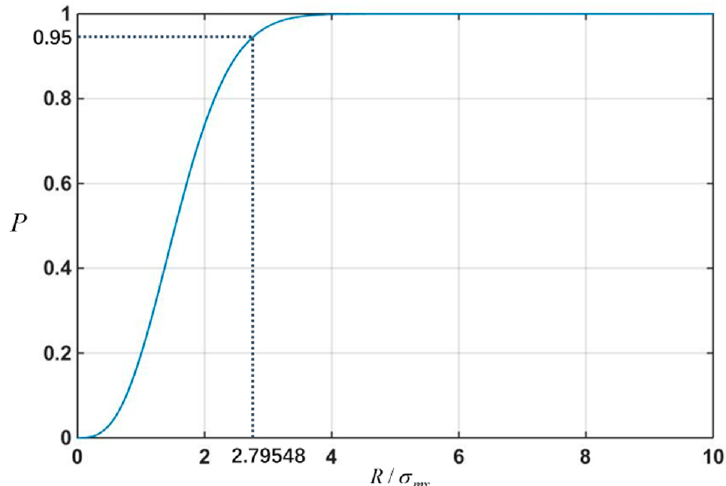
Figure 5. Numerical integration results of P and R / σ mx . Take the value to calculate the allowable error ξ = 10 − 6 ( | P − 0.95 | < ξ ),when R / σ mx = 2.79548, the probability is 95%. It can be obtained that the three-axis radius lengths of the integral ellipsoid domain are: R x = 2.79548 σ mx , R y = 2.79548 σ my , R z = 2.79548 σ mz . The ANP of the FMS in three-dimensional space can be represented by R x , R y and R z . As shown in Figure 6, the volume of the EEP model is smaller than that of the SEP model, and the disparity increases rapidly with the increase of the ratio of three-axis standard deviation. That is, under the same probability, the EEP model is closer to the real position error and has higher evaluation accuracy.